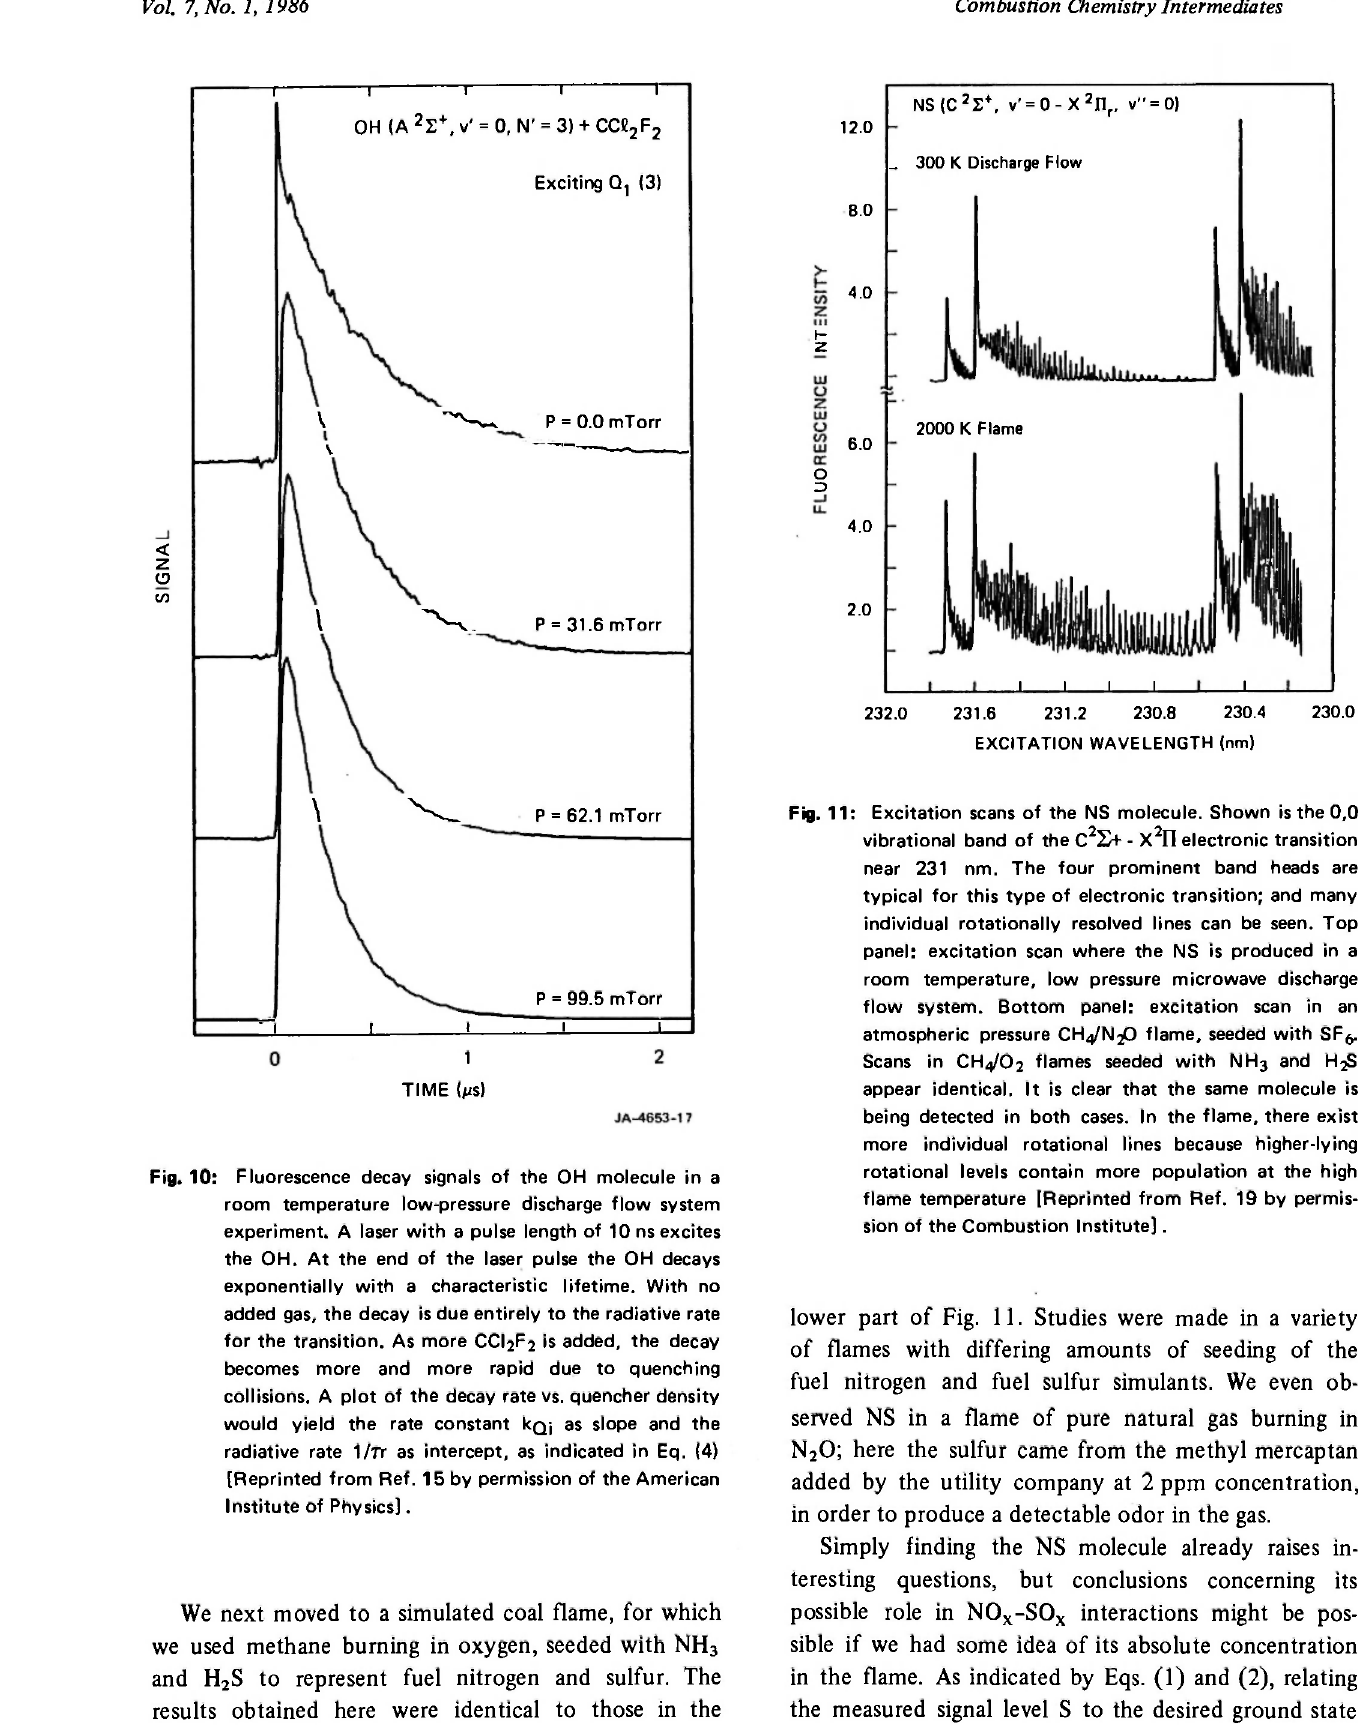
Fig. 10: Fluorescence decay signals of the OH molecule in a room temperature low-pressure discharge flow system experiment. A laser with a pulse length of 10 ns excites the OH. At the end of the laser pulse the OH decays exponentially with a characteristic lifetime. With no added gas, the decay is due entirely to the radiative rate for the transition. As more CCI2F2 is added, the decay becomes more and more rapid due to quenching collisions. A plot of the decay rate vs. quencher density would yield the rate constant kQj as slope and the radiative rate 1/rr as intercept, as indicated in Eq. (4) [Reprinted from Ref. 15 by permission of the American Institute of Physics].